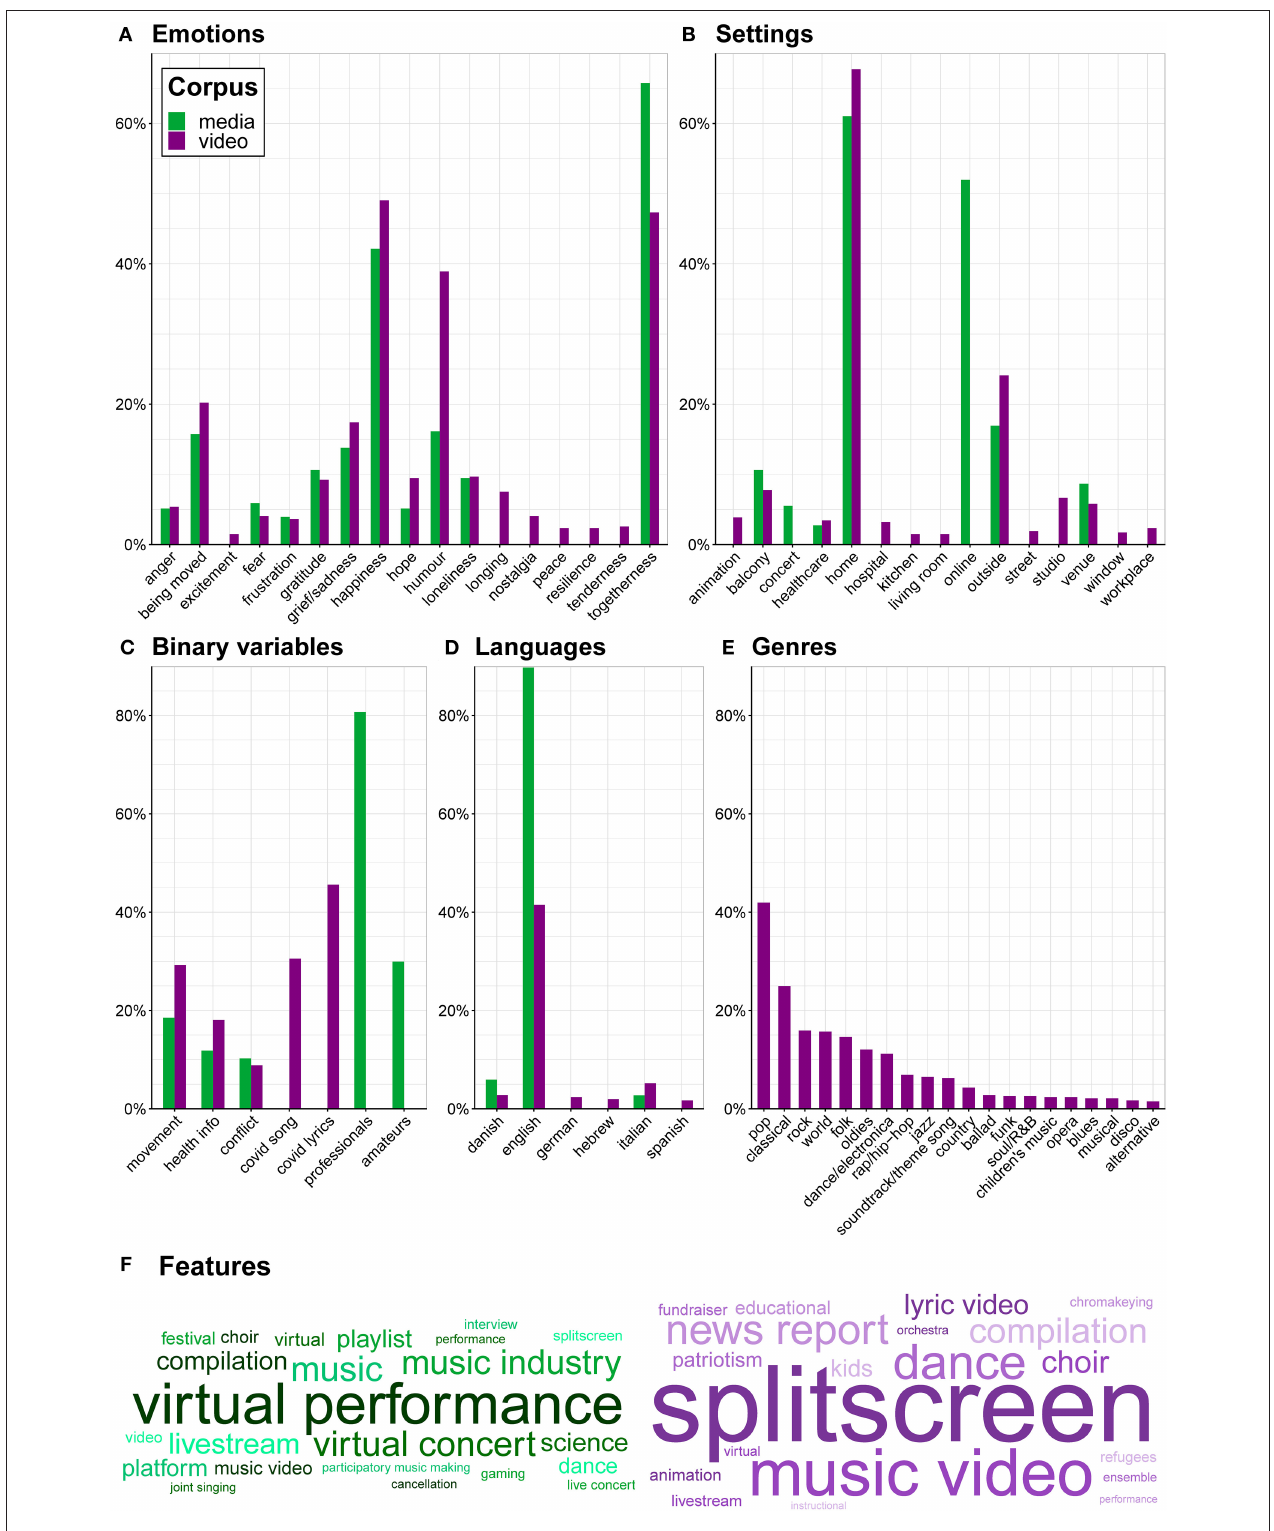
FIGURE 2 | Bar charts for (A) emotions, (B) settings, (C) binary-coded variables, (D) languages, and (E) musical genres in the media (green) and music video (purple) sub-corpora. The y-axes depict proportion of all music video or media items in which a given term is featured. Because nearly all included variables–except for binary variables in (C) –allow for coding of multiple values for one item, summed percentages often exceed 100%. Note that (D) refers to language of lyrics in the case of video